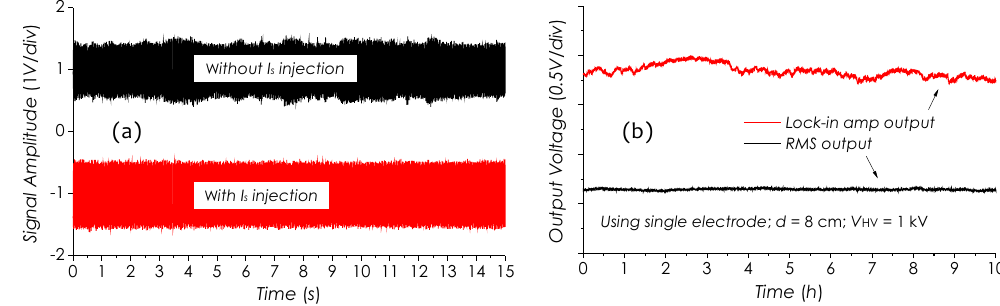
Figure 14. ( a ) Measured E -field signals with/without I s ( t ) injection, ( b ) error signal trace from lock-in amplifier and field strength trace recorded for 10 h.